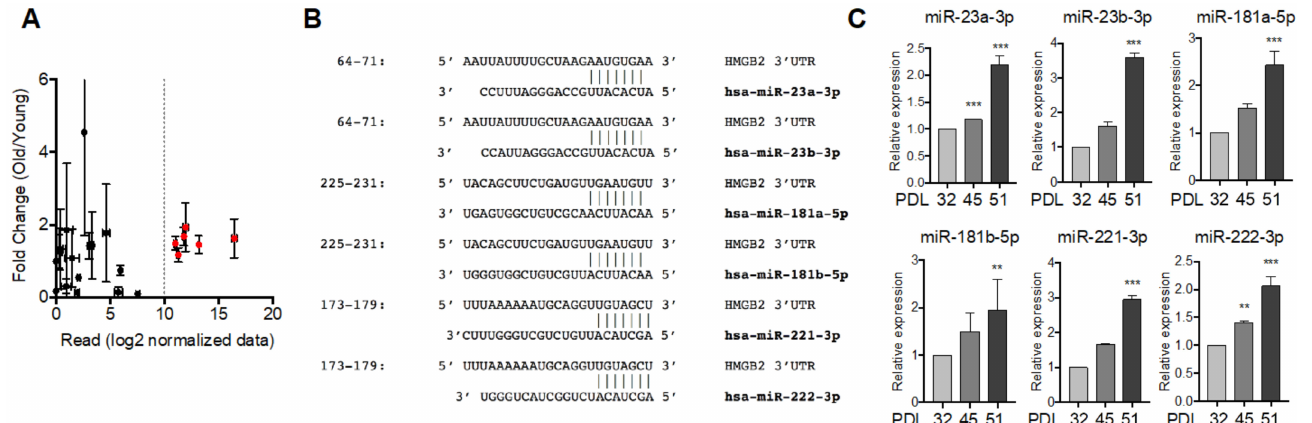
Figure 4. Screening of miRNAs targeting HMGB2 and induced during senescence in MVECs. ( A ) Twenty-five candidate miRNAs that targeted HMGB2 were plotted using the normalized ex- pression level as the x-axis and the induction fold of expression in old MVECs as the y-axis. Red dots represent the finally selected miRNAs. ( B ) Sequence alignment of miRNA with the possible target sequence in the 3 (cid:48) UTR of HMGB2 . Numbers indicated the location from the stop codon of the HMGB2 gene. ( C ) Expression of miRNAs was analyzed by qRT-PCR in serially passaged MVECs. 3 (cid:48) UTR, 3 (cid:48) untranslated region. ** p < 0.01. *** p <